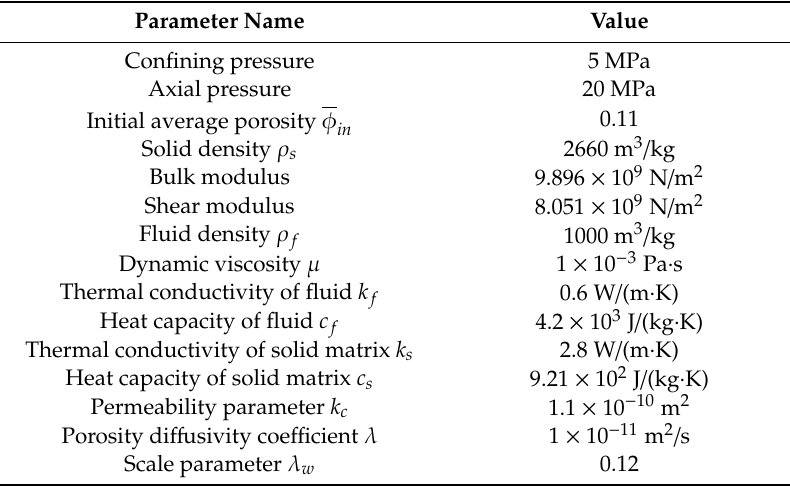
Table 1. The model parameters.